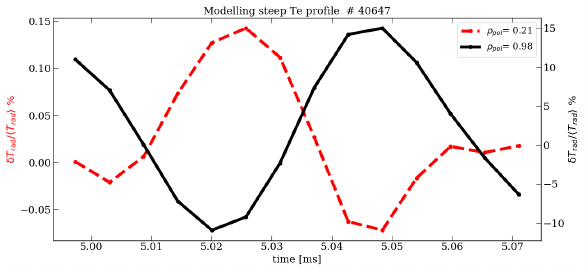
Figure 8. ECRad modeling: modelled time evolution of the radi- ation temperature fluctuations for the on-axis heating case. Black solid line shows the channel at the plasma edge while red dashed line represents the behaviour in the